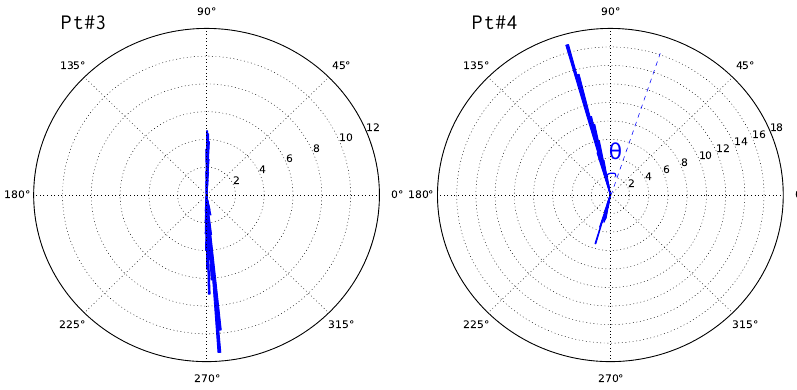
Figure 8. Directional distribution of available tidal stream power energy per unit area P (expressed in percentages of total power density over a year) in conditions of near rectilinear flow (point #3) and current directional asymmetry (point #4).